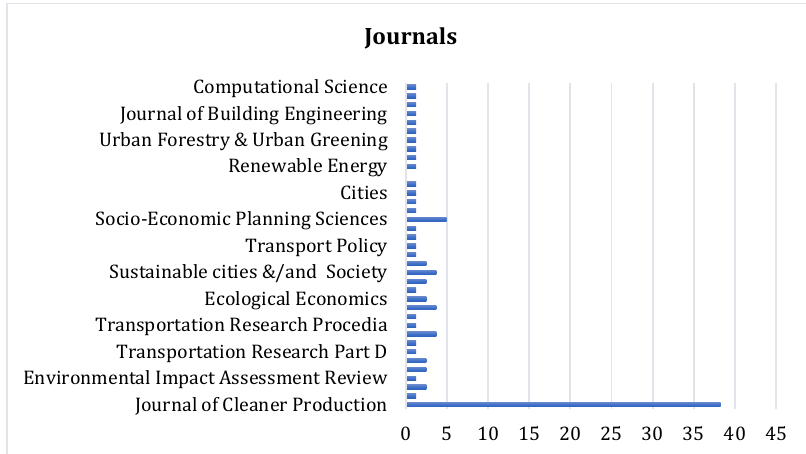
Figure 6: Journals’ distribution according to the number of articles